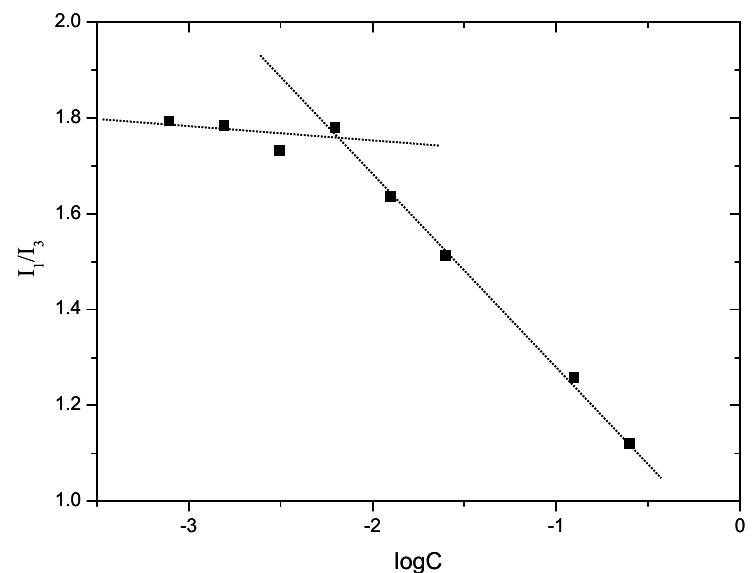
Figure 4. Variation of the fluorescence intensity ratio of I 1 /I 3 against the logarithm of FA-CS-DA concentration.